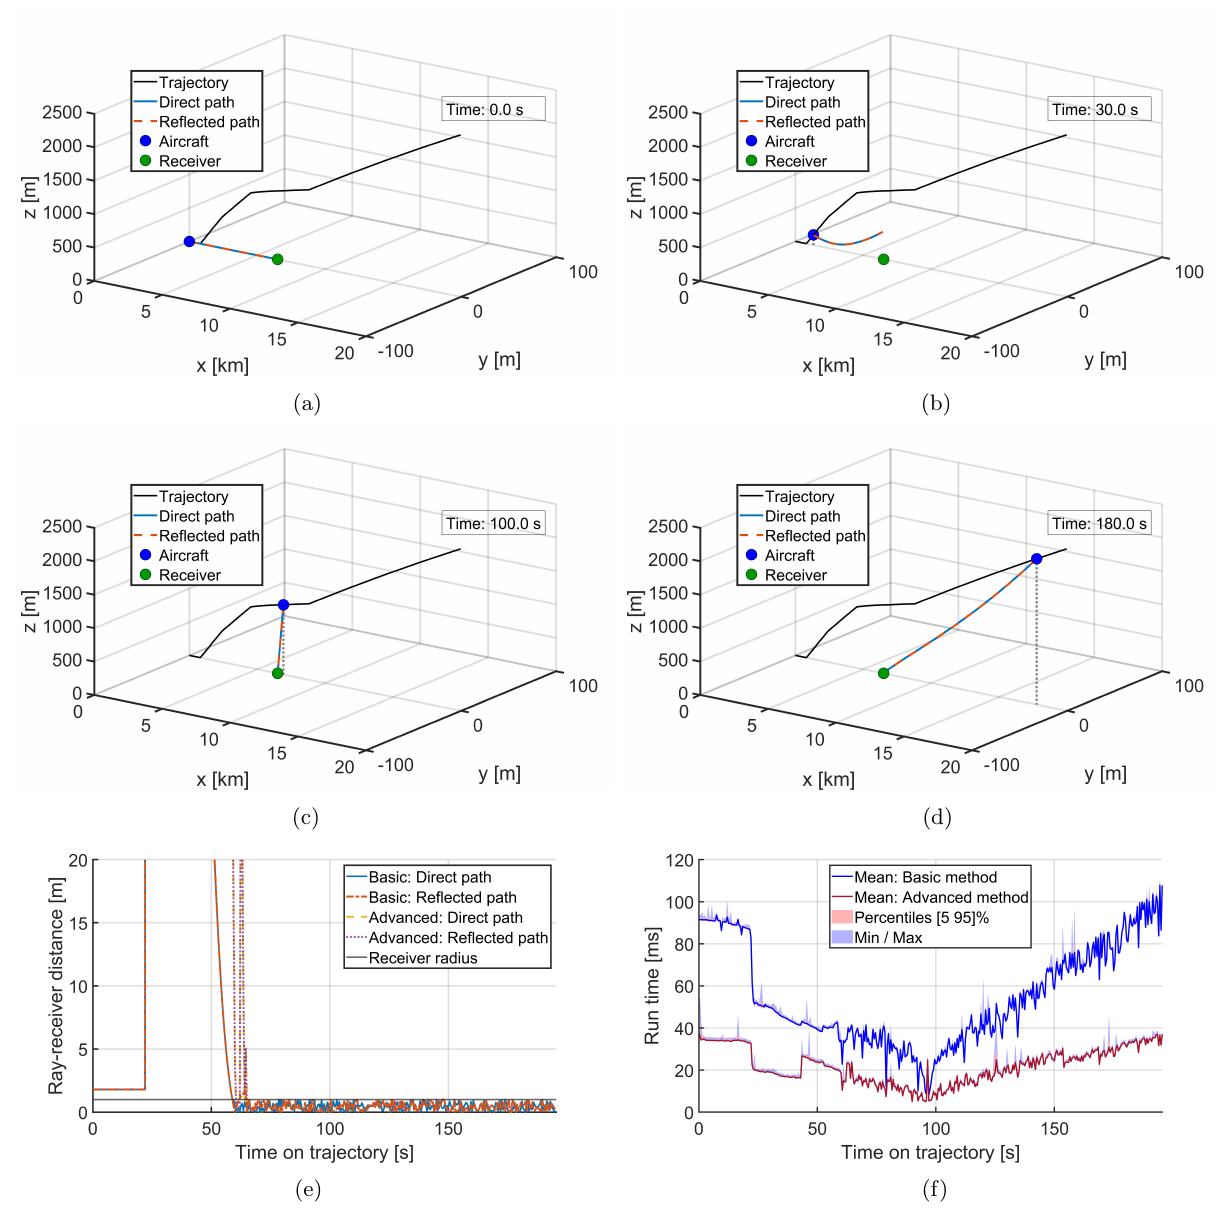
Figure 8. Performance of adaptive ray zooming approach during aircraft fl yover. (a) Eigenray results while aircraft is grounded. (b) Eigenray results during take-off phase. (c) Eigenray results while aircraft is above receiver. (d) Eigenray results while aircraft resides beyond receiver. (e) Distance between eigenrays and receiver using basic and advanced ray zooming method, and (f) C++ run-times of adaptive ray zooming method using the basic and the advanced